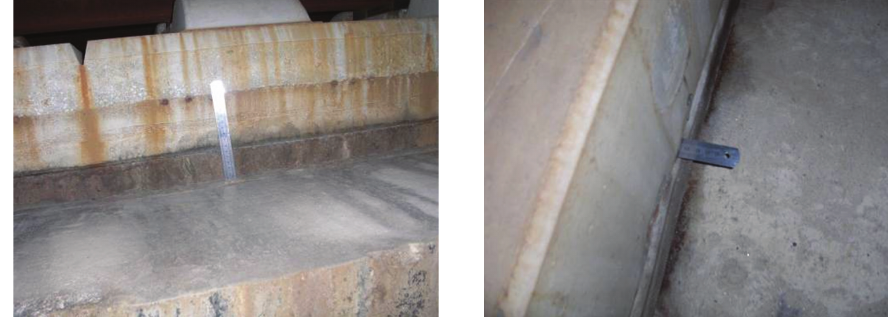
Figure 1: Debonding between slab and CA mortar layer of CRTS II slab ballastless track.